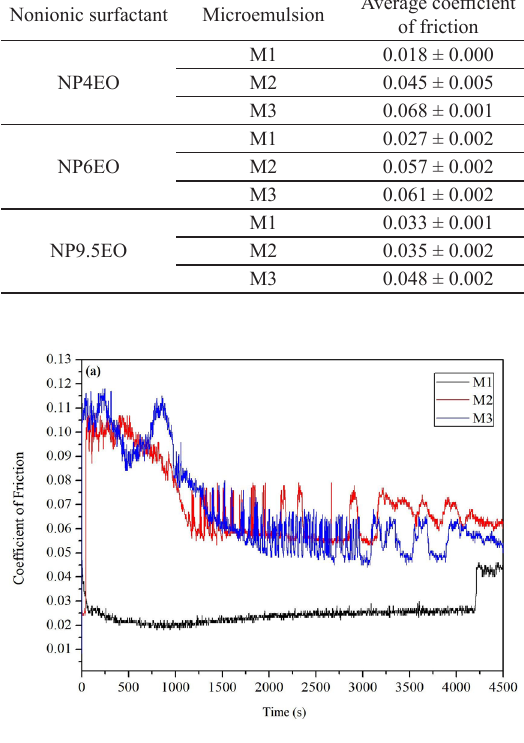
Table 8. Coefficient of friction obtained with the microemulsion systems. Nonionic surfactant